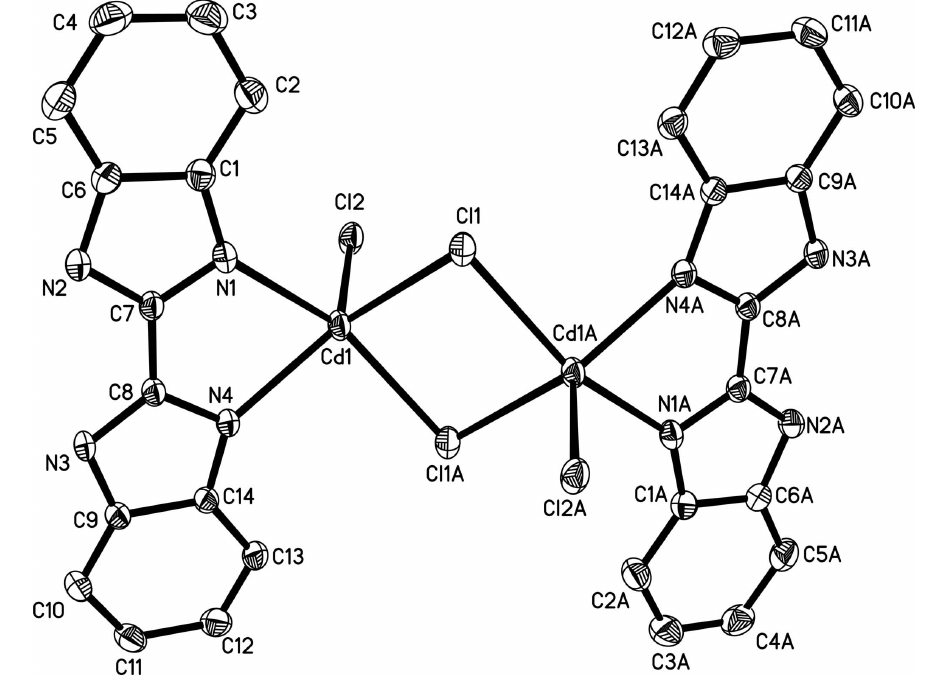
Figure 1 The structure of the title compound with displacement ellipsoids at the 30% probability level.